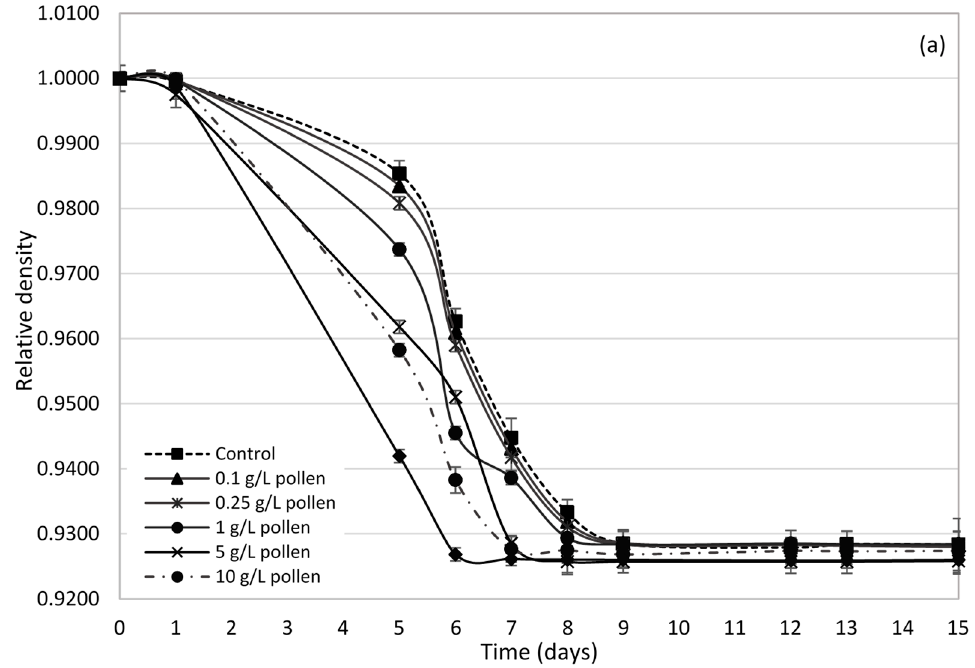
Figure 1. Cont. Figure 1.